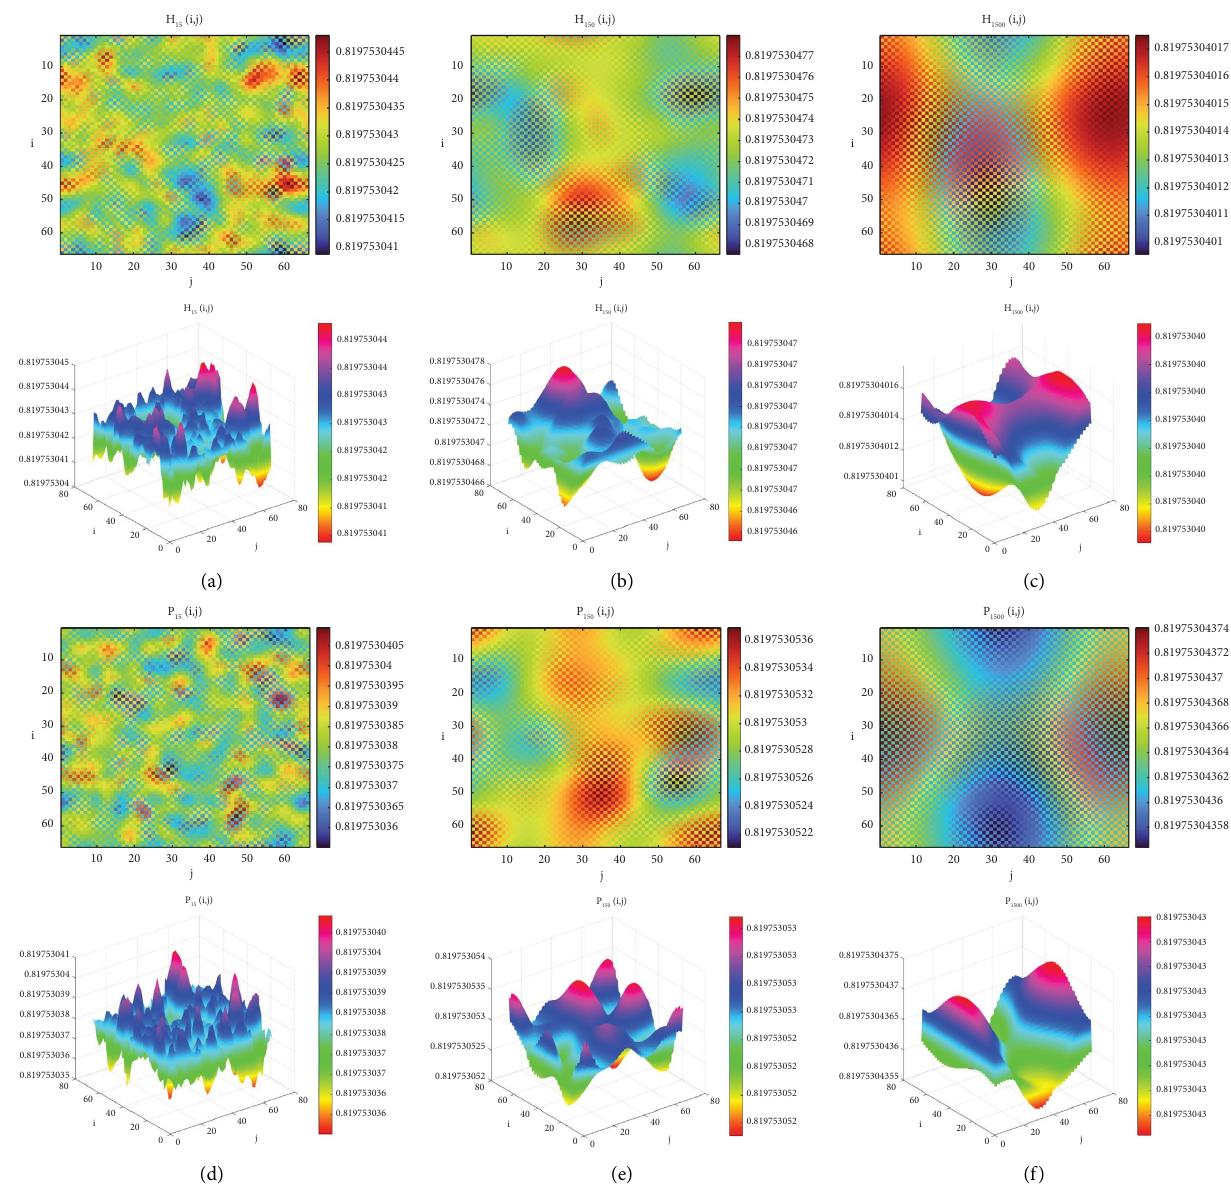
Figure 24: R � 2 , k � 1, c � 0 . 8, σ ∗ � 0 . 278655, σ � σ ∗ , ( d which is consistent with the case of Corollary 3(8), a Neimark-Sacker-Neimark-Sacker bifurcation occurs, parasite and host populations generally exhibit periodic oscillatory behavior in two-dimensional